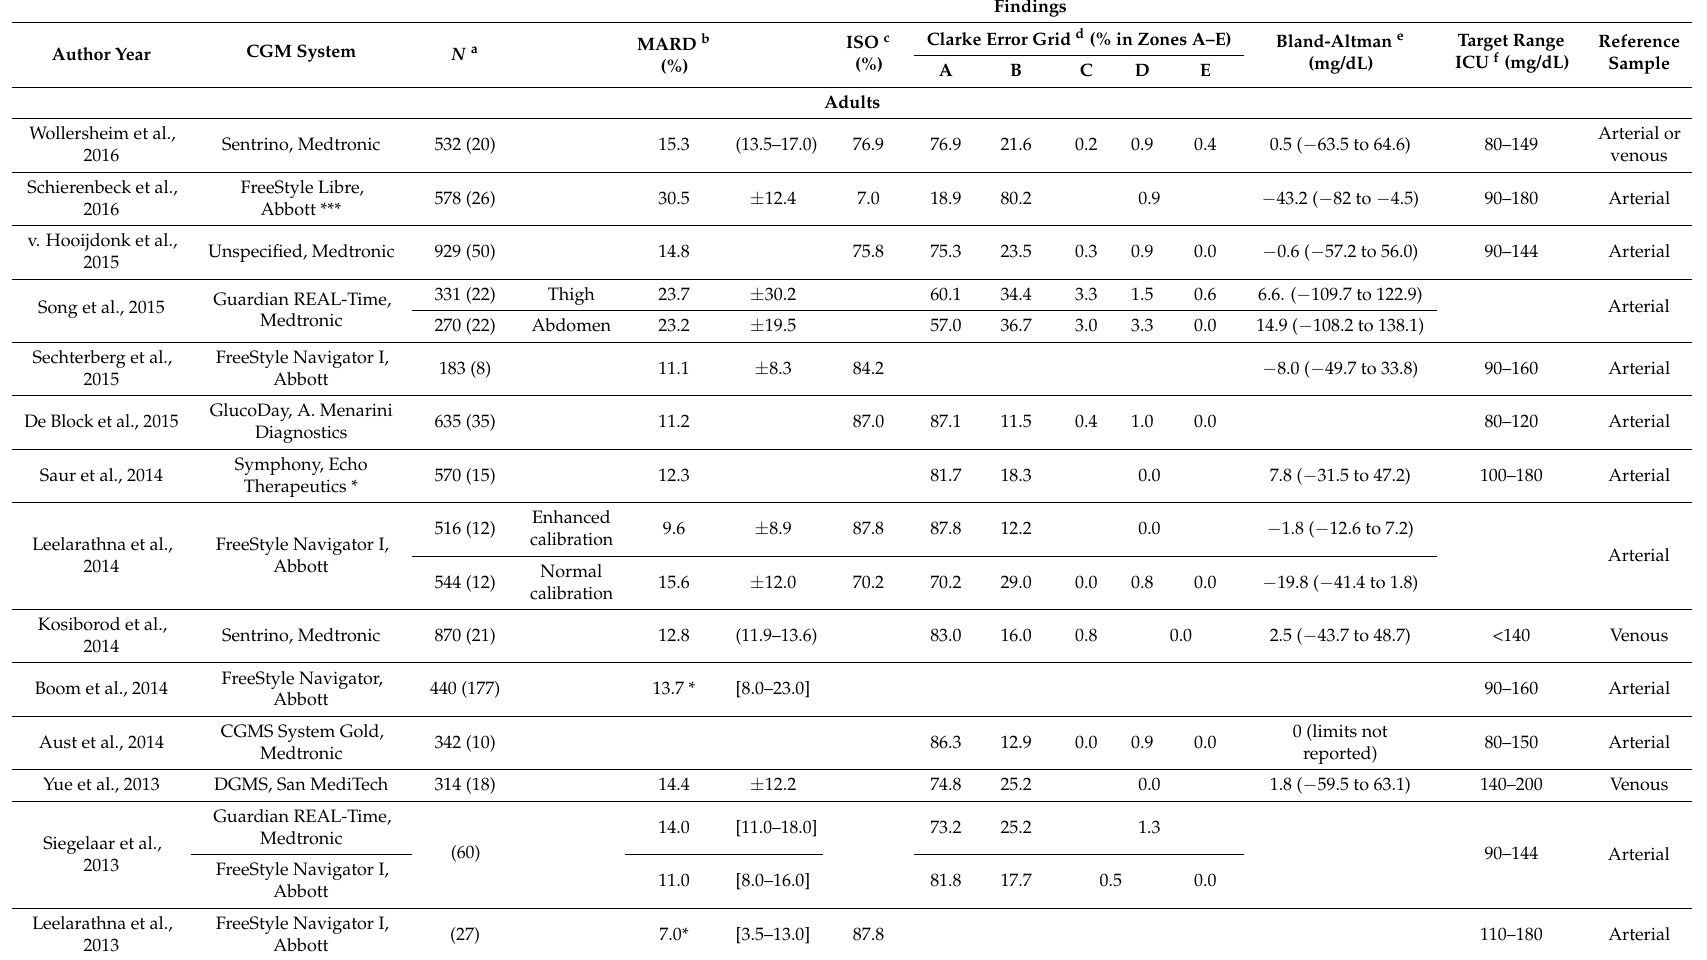
Table 3. Reported accuracy outcomes of the included studies that assessed subcutaneous continuous glucose monitoring (CGM) systems ( n =